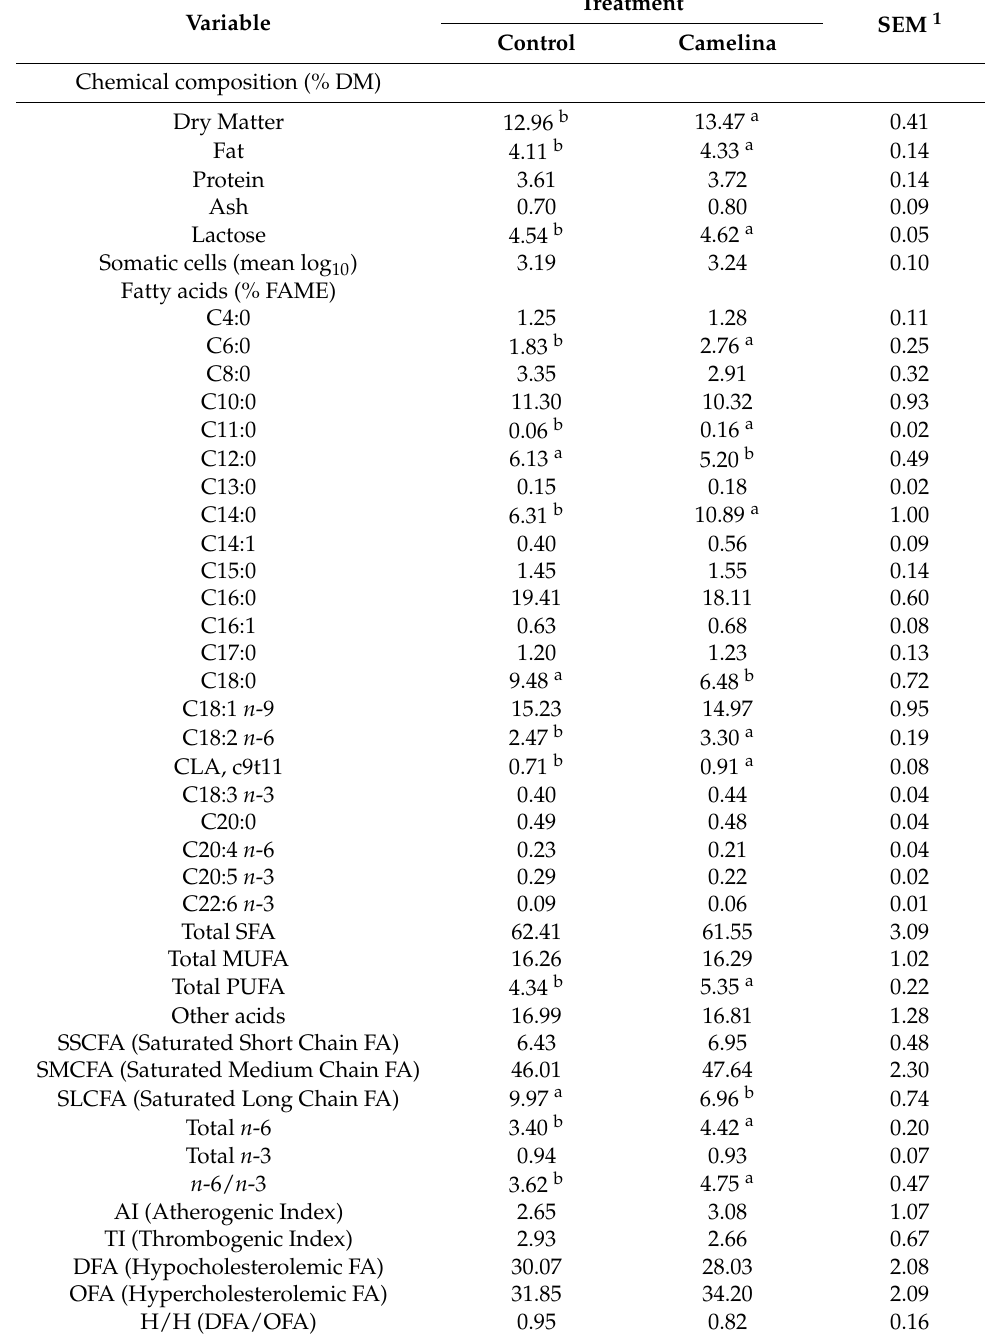
Table 2. Chemical and fatty acid composition of goat milk (mean ± SEM).